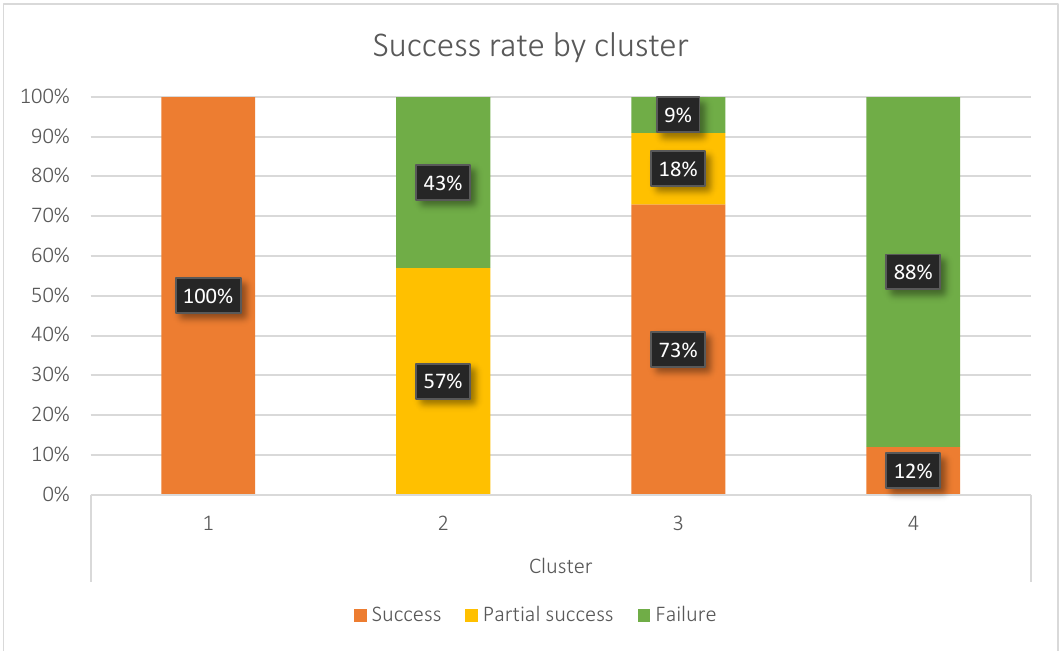
Figure 7. Success rate by cluster.